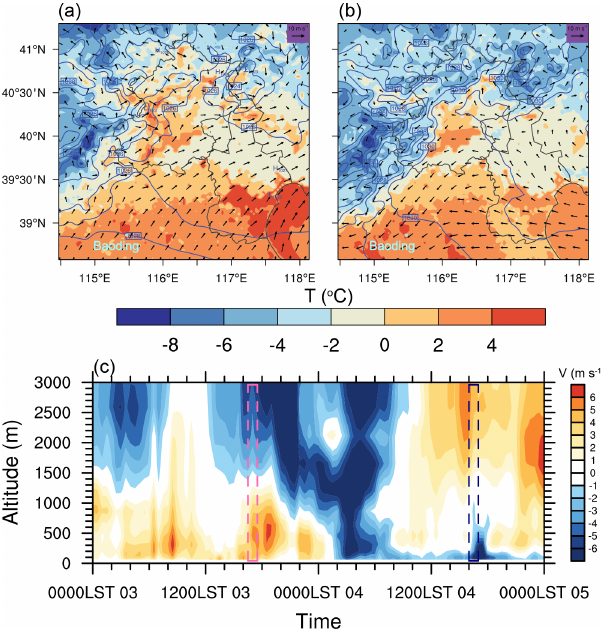
Figure 5. The EXP_Ctrl simulated synoptic patterns during the study period. (a–b) The surface wind, temperature, and pressure field during the aircraft observation periods on 3 and 4 January, re- spectively. (c) The temporal evolution of the meridional wind speed over Baoding. The green dots in panels (a) – (b) denote the location of Baoding. The pink and blue dashed boxes in panel (c) correspond to the aircraft observation periods on 3 and 4 January,